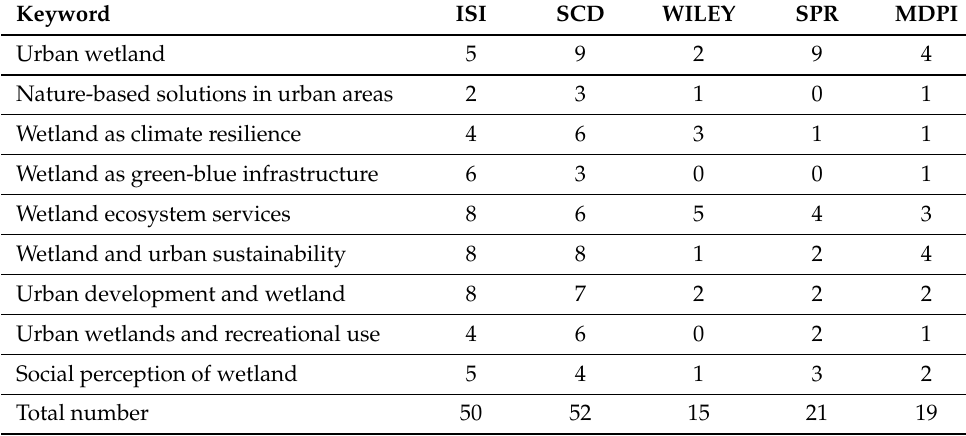
Table 1. The keywords, numbers of articles, and the names of journal